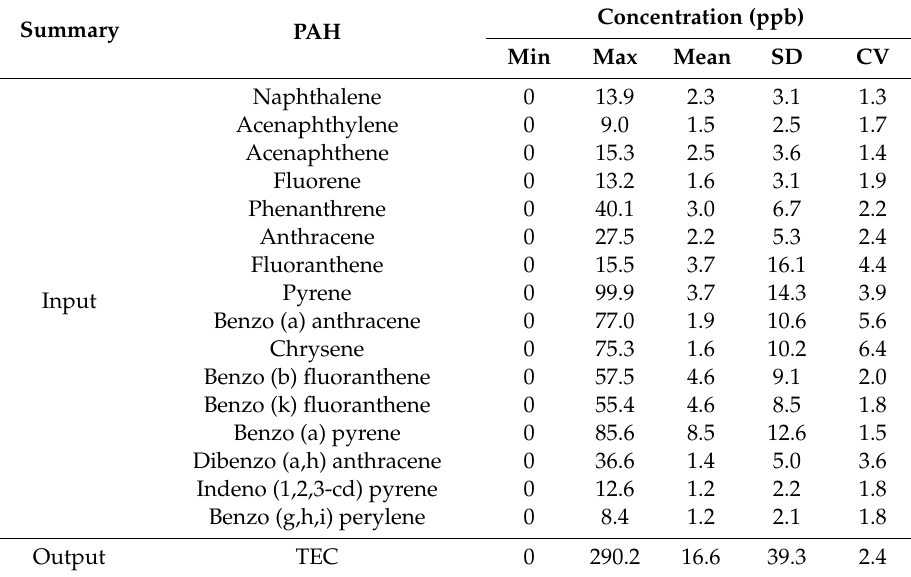
Table 13. Summary of the input and output parameters for the wet